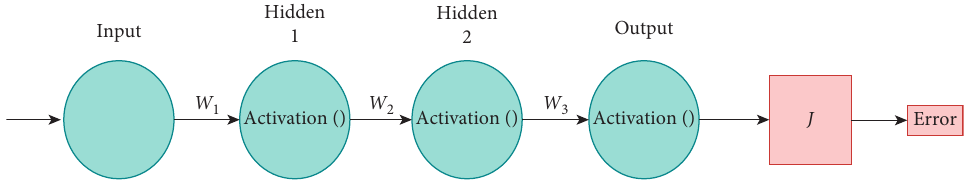
Figure 5: The simplified M-learning model learning